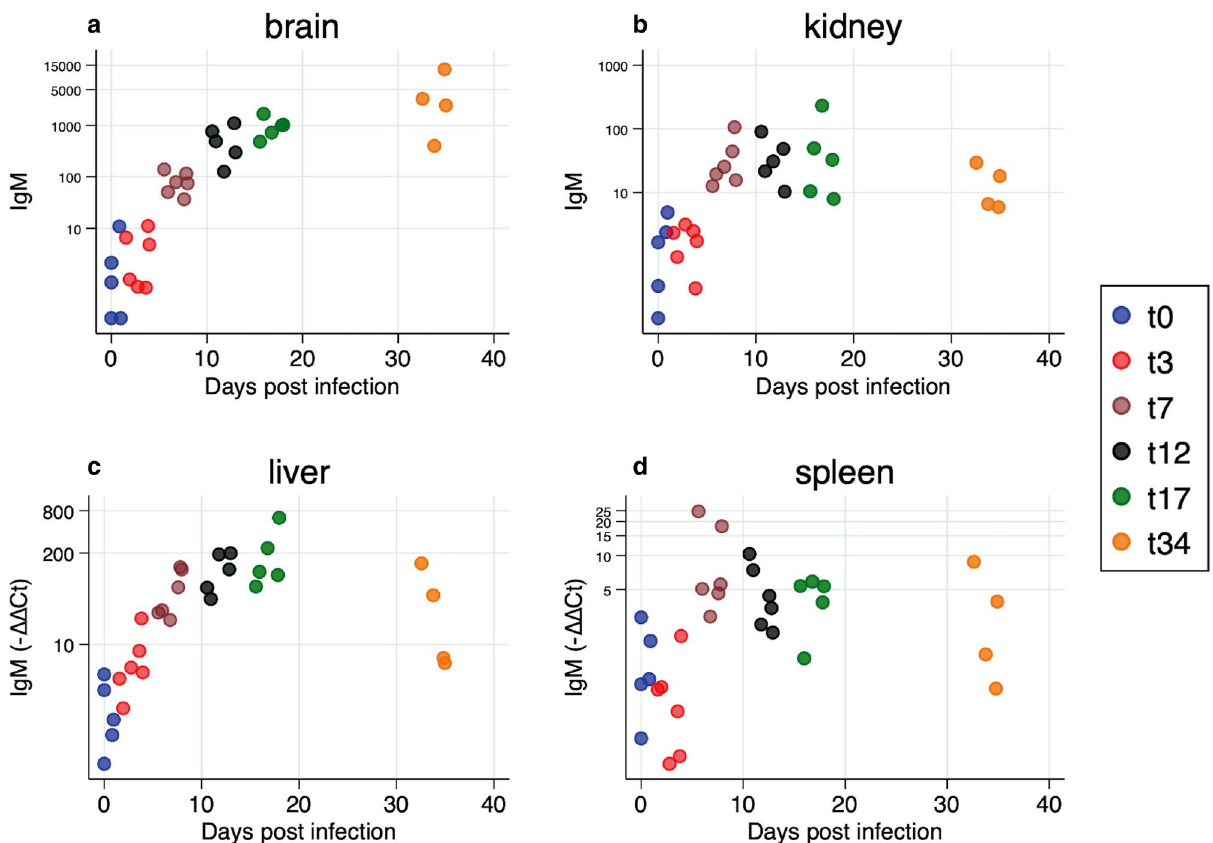
Figure 7. IgM mRNA expression in ( a ) brain, ( b ) kidney, ( c ) liver and ( d ) spleen over the course of infection showing a gradual increase from day 7 and onwards for all organs. There is similar pattern in brain and liver, while kidney and spleen are more variable, but an increase is seen during the first part of the challenge. Brain is highest at 34 dpc, different from all other